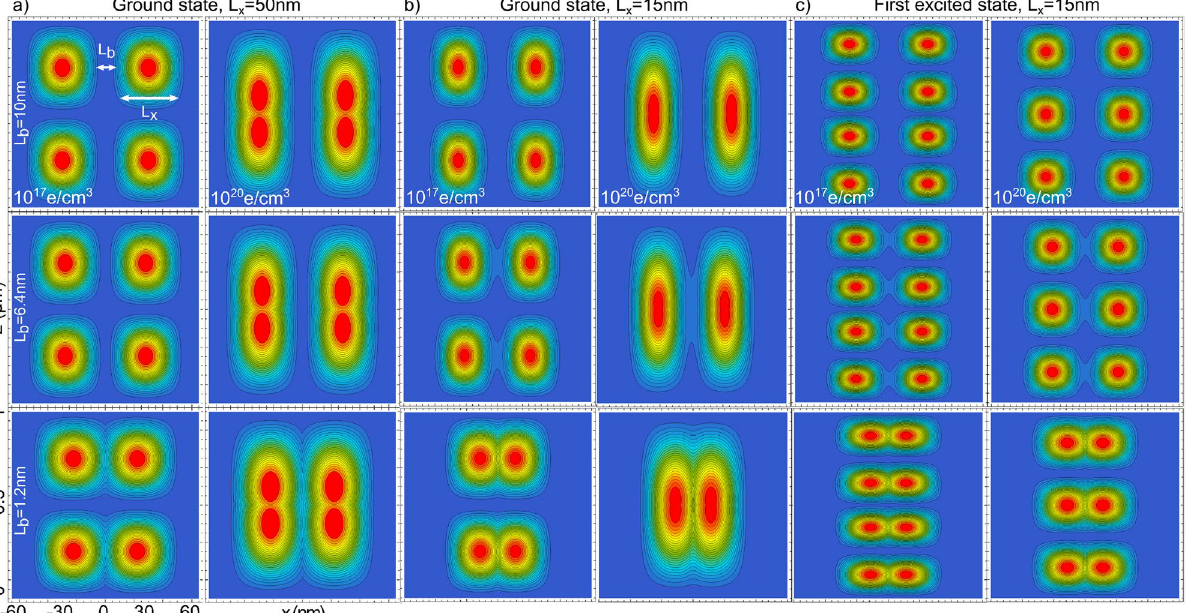
50 nm, ( b ) ground state for L =